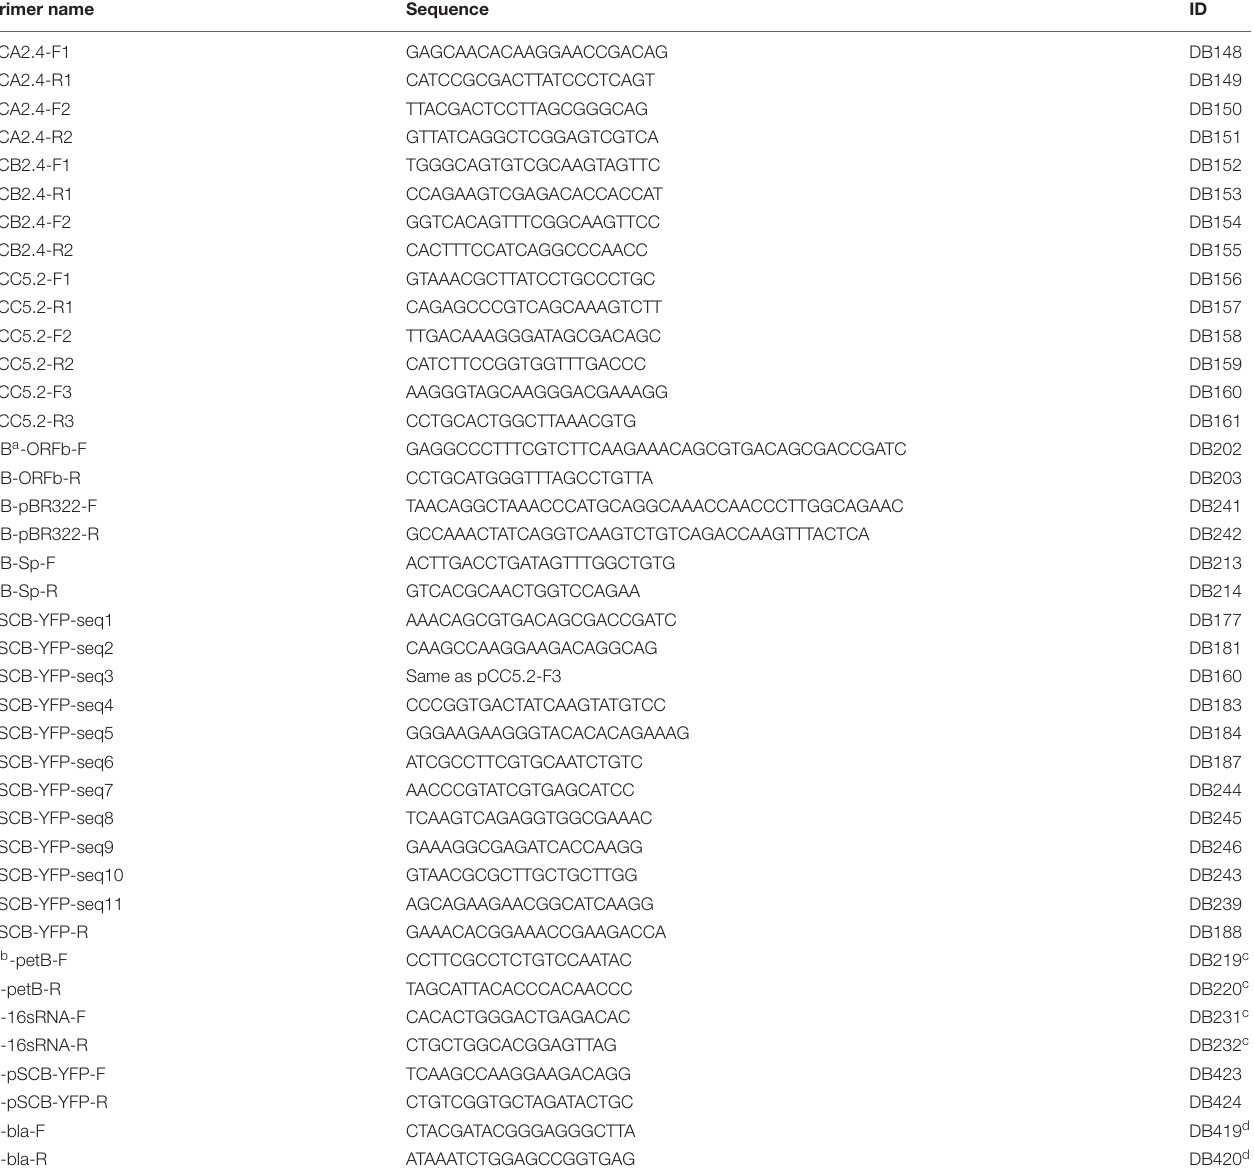
TABLE 2 | Oligonucleotides used in this